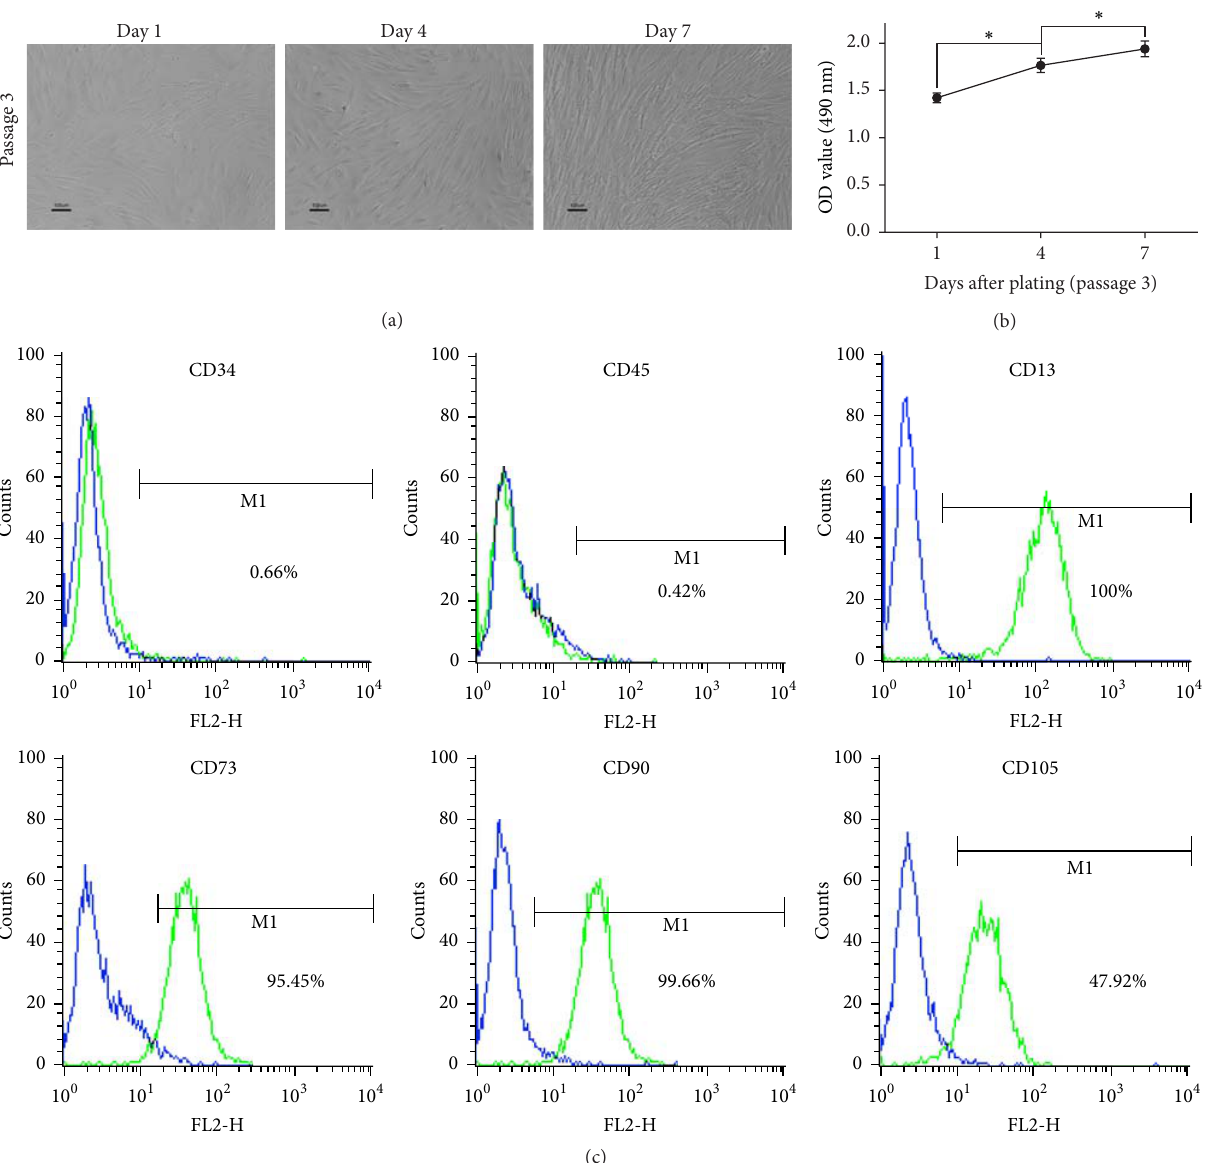
Figure 1: Characterization of UC-MSCs. (a) Morphological changes and characterization of UC-MSCs. (b) The viability of UC-MSCs after plating from day 1 to day 7 measured by MTT assay. (c) The expression of cell surface markers measured by flow cytometry. UC-MSCs positively expressed CD13, CD73, CD90, and CD105 but negatively expressed CD34 and CD45. ∗ represents 𝑝 < 0.05